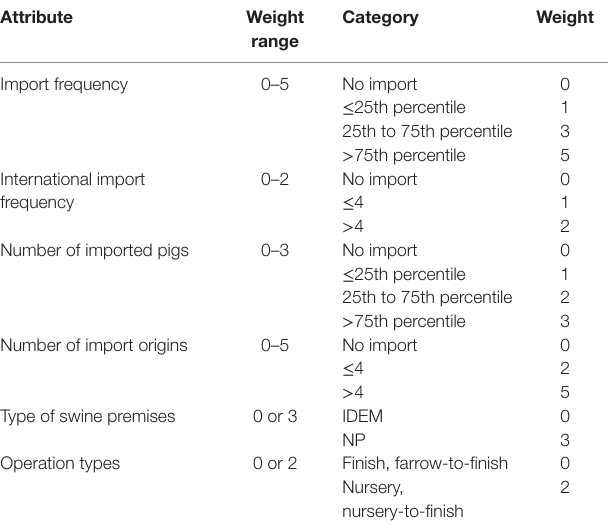
TaBle 3 | The scoring system for the premises-level risk metrics for selecting the most likely classical swine fever outbreak scenarios in indiana, United